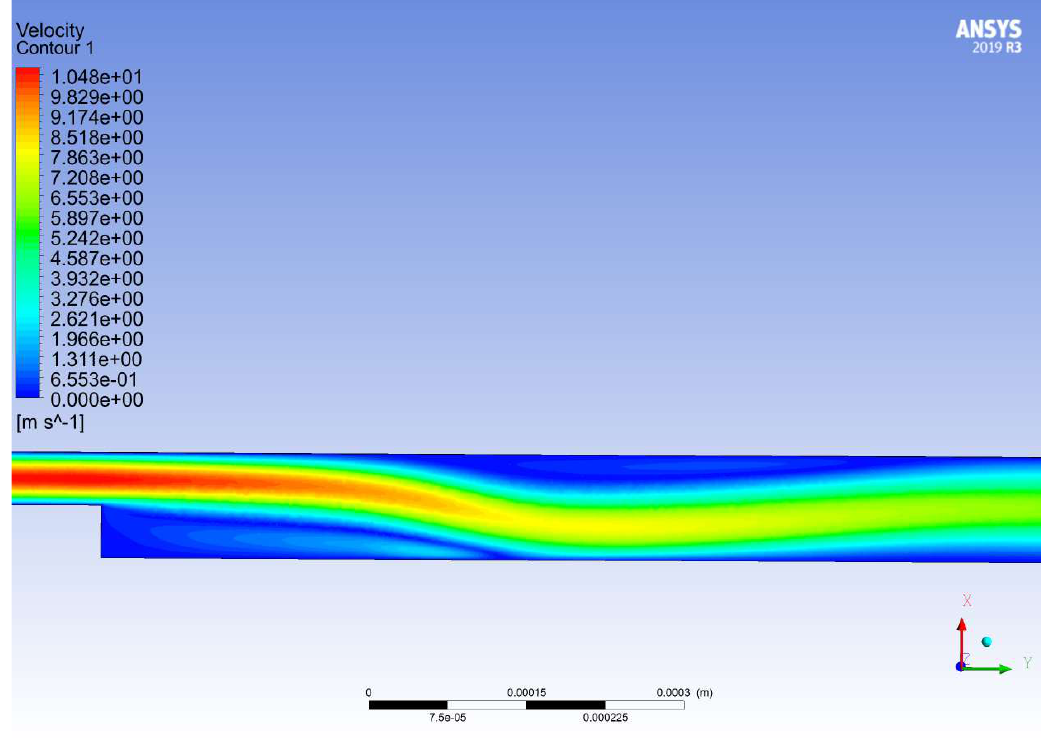
Figure 14. Velocity distribution in the Reynolds Stress turbulence model.